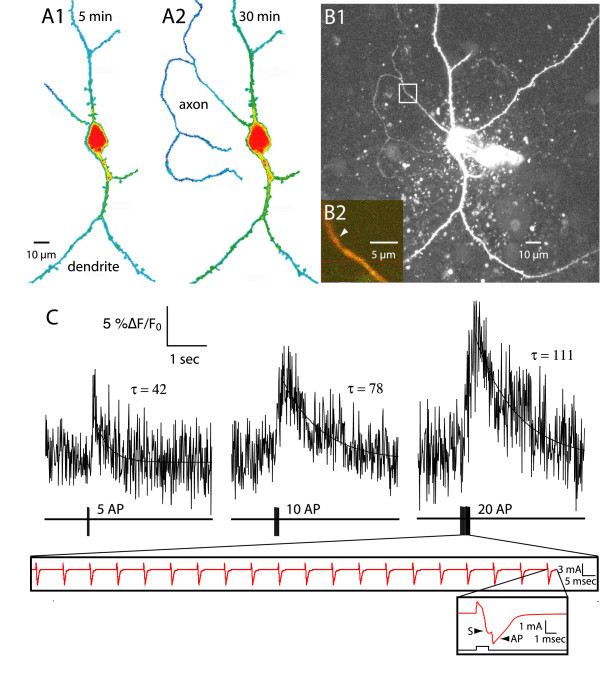
Delayed dye diffusion identifies MSN axons. A. A single MSN was loaded with OG1 and Alexa594 through the patch pipette and imaged by 2PLSM at 5 and 30 min after entering whole cell mode. Fluorescence intensity is shown in pseudocolor (ImageJ). Projection images (A1) were created from a z series of confocal Alexa594 images. At 5 min, the dendrites and proximal axon were filled. At 30 min (A2), dendritic labeling showed no significant change, while the axon was now clearly labeled. Dendritic processes were studded with spines, in contrast to the single axonal process, which was free of spines. B. The recorded MSN is shown in a projection image (B1) made from the full confocal z series of Alexa594 images (50 sections at 1 μm intervals). The area outlined in panel B1 (white rectangle) is shown enlarged in the inset (B2). This stretch of axon contained one hot spot, indicated by the arrowhead (B2). C. Presynaptic Ca2+ responses were evoked by trains of 5, 10 or 20 AP's. The raw Ca2+ responses showed the typical waveform of AP-induced Ca2+ responses, with a fast rising and slow decay phase. The decay followed a single exponential curve; the decay time constant τ (in msec) is indicated on each panel. Raw traces of evoked AP's are shown in the bottom panel (red trace). Note that the 20 depolarizing pulses evoked 20 AP's without failures. The last AP is shown magnified in the inset (right bottom), with the depolarizing pulse below; the end of the stimulus artifact (S) is seen as an inflection preceding the unclamped axon spike (AP).